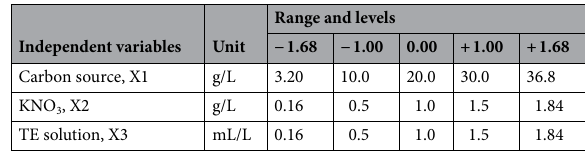
Table 3. Experimental code and actual